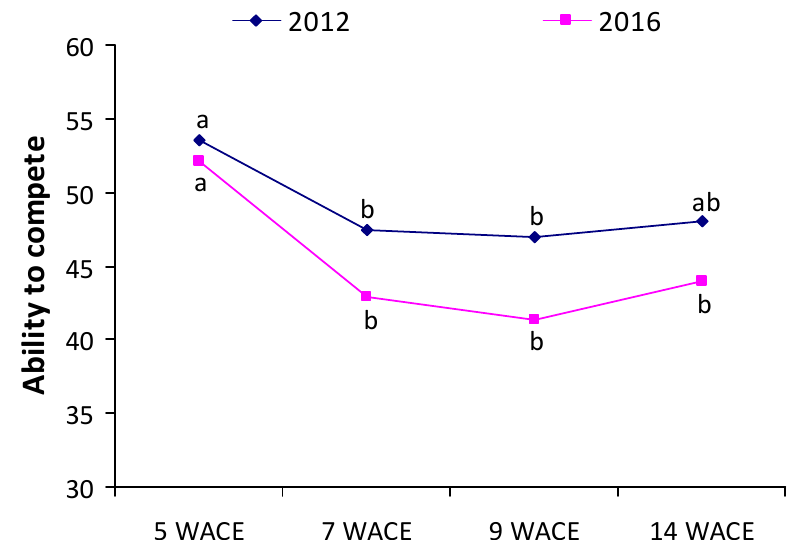
Figure 7. Ability to compete (AC) index at various weeks after crop emergence (WACE) in the first and second growing seasons. Different letters in each growing season indicate statistically significant differences at p < 0.05.